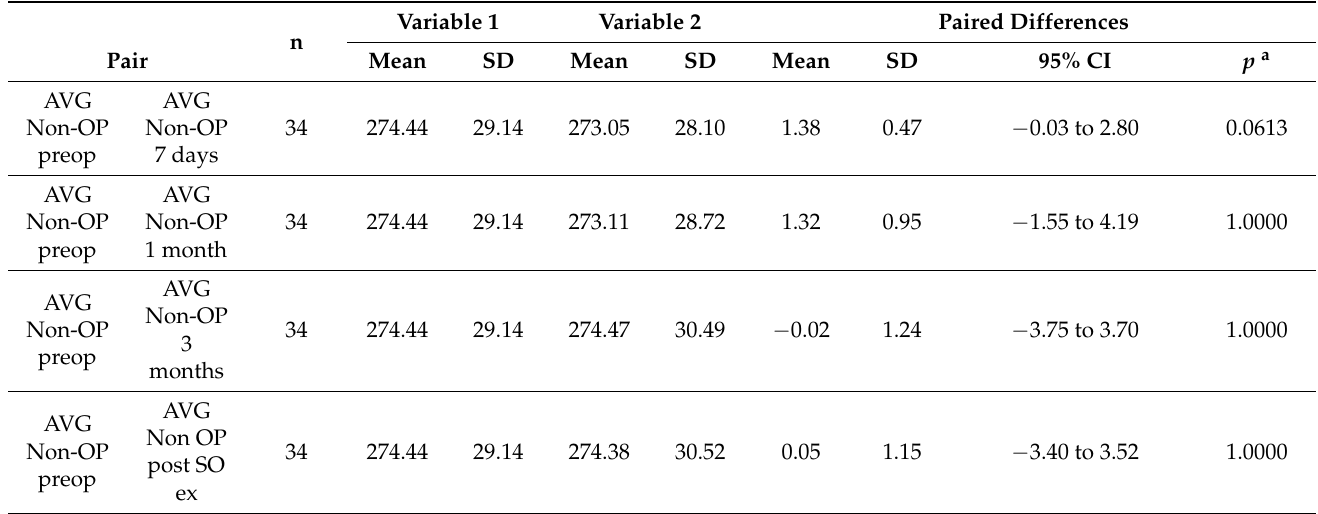
Table 7. Average macular thickness cube—AVG ( µ m) in non-operated eyes.